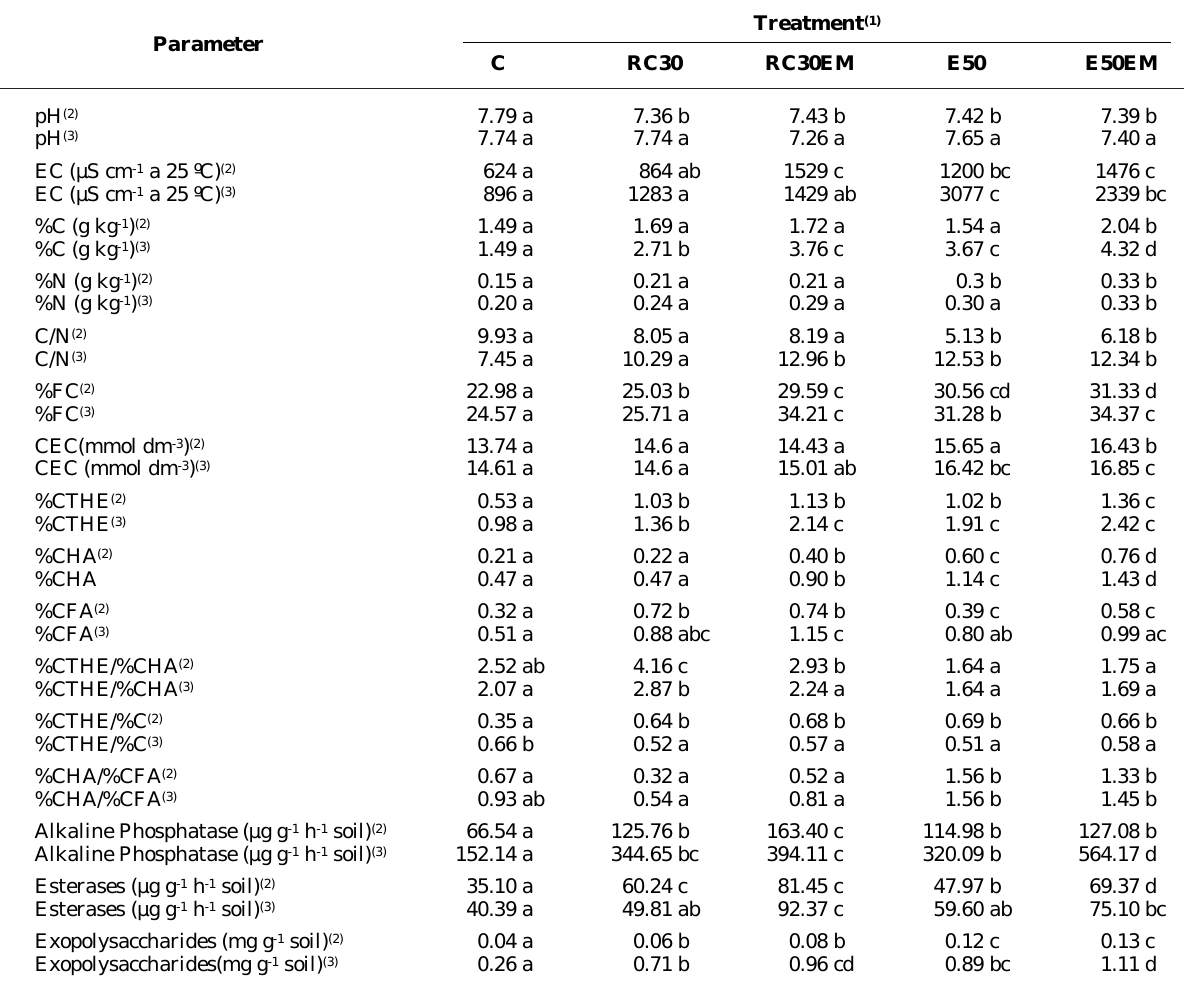
Table 1. Physical, chemical and microbiological parameters of a claim loam soil with kinds and amounts of organic matter incorporated, before and after